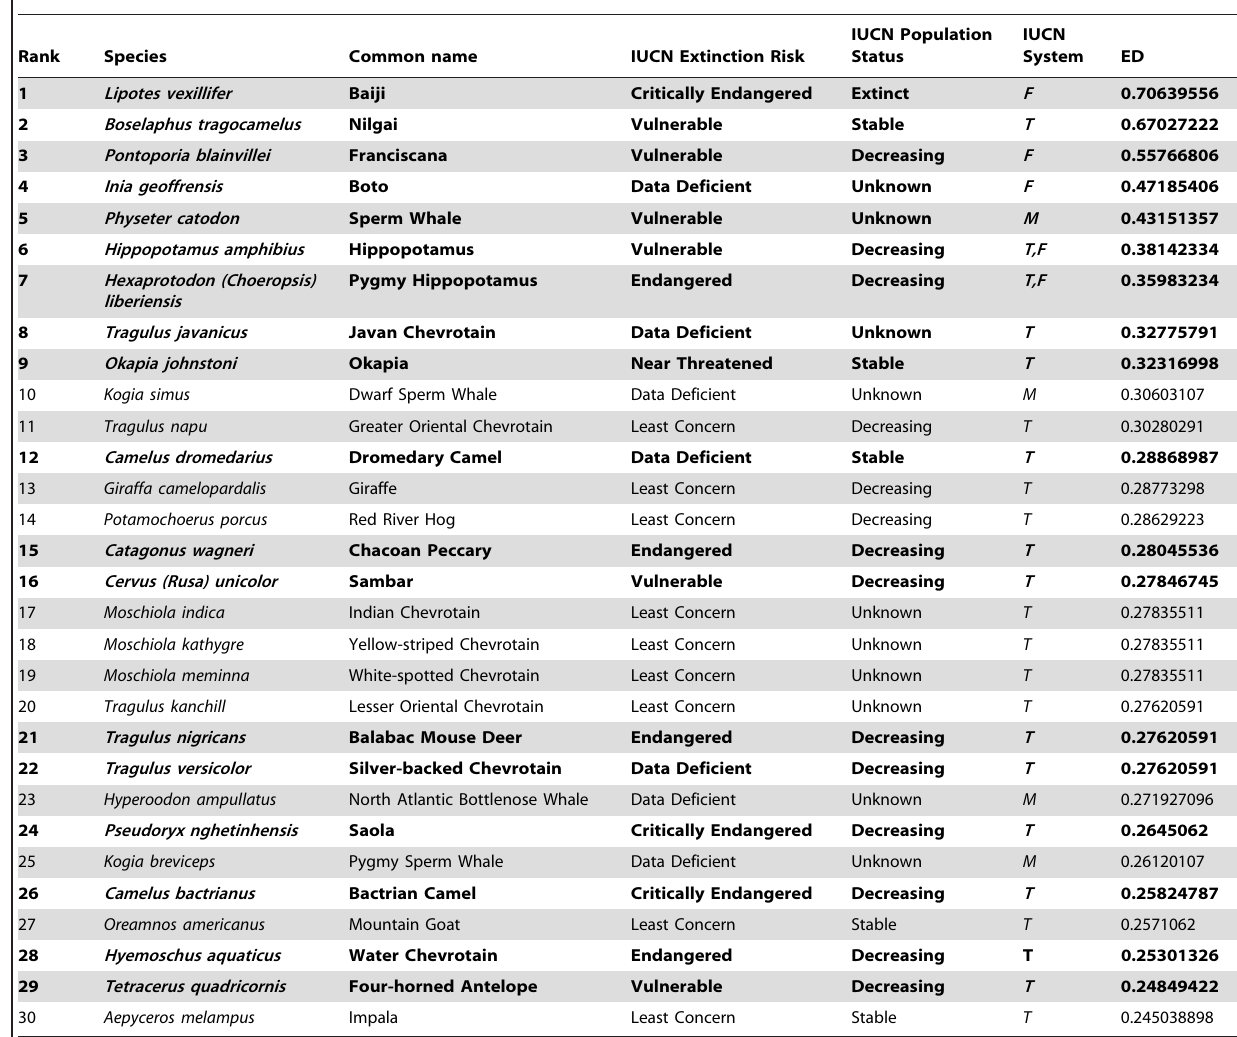
Table 4. Top 30 most evolutionarily distinct (ED) species for